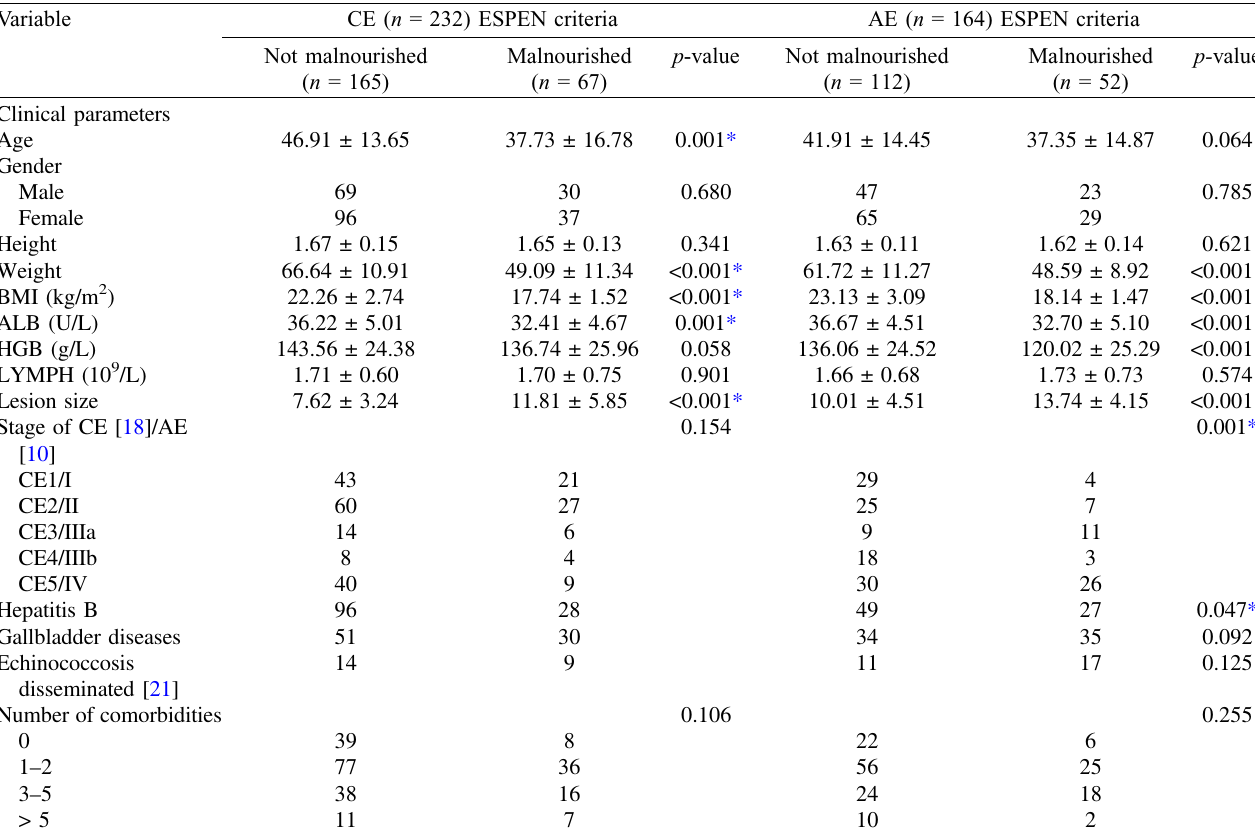
Table 1. Characteristics of